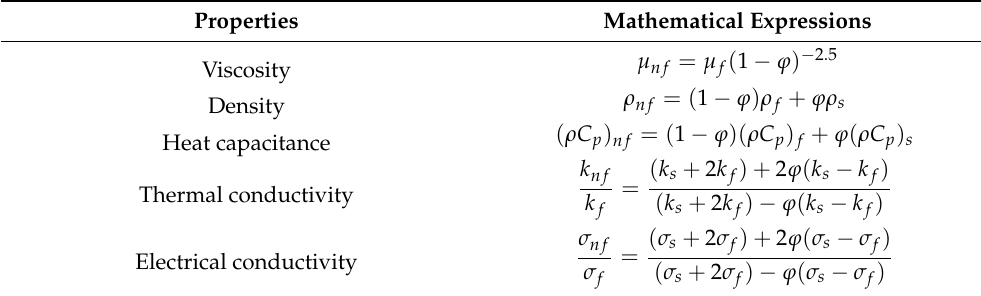
Table 1. Mathematical expression of nanofluid properties [5].